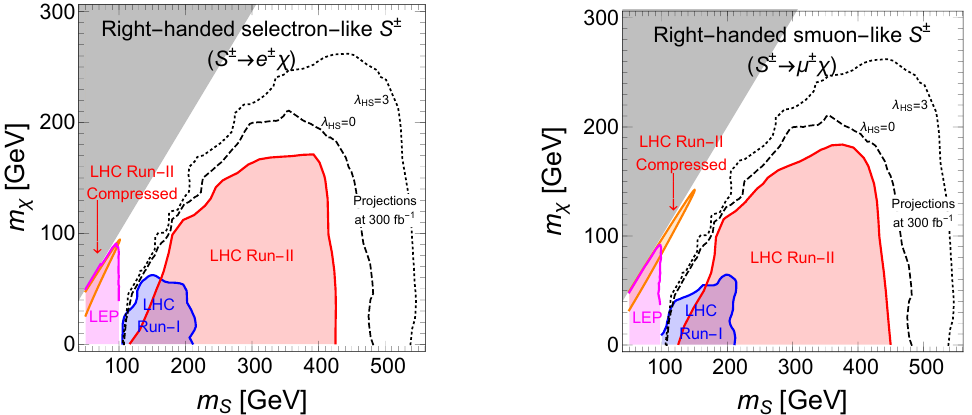
Figure 3 . The current constraints for right-handed selectron-like and right-handed smuon-like scalar S in the m - m plane. The shaded regions are exclusions from LEP [76], LHC Run-I χ S ( 20 . 3 fb − 1 ) [73] and LHC Run-II ( 139 fb − 1 ) [74, 75]. The black lines are projections for the LHC reach at 300 fb − 1 with λ = 0 (solid) and λ = 3 HS HS